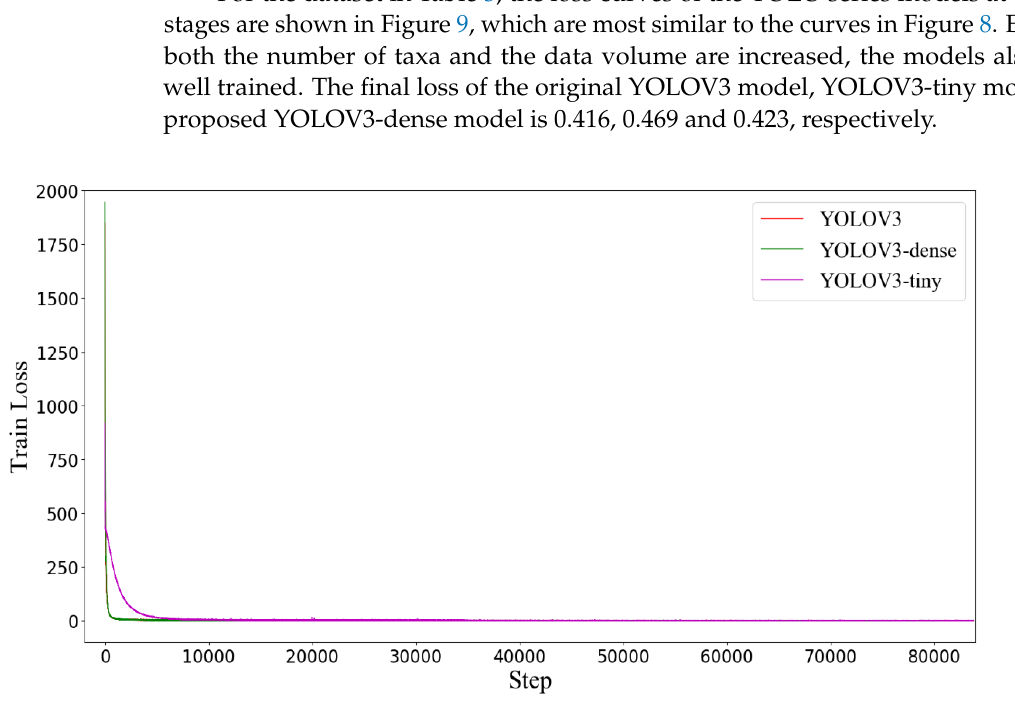
Figure 9. Loss curves of the proposed model and other YOLO series comparison models.